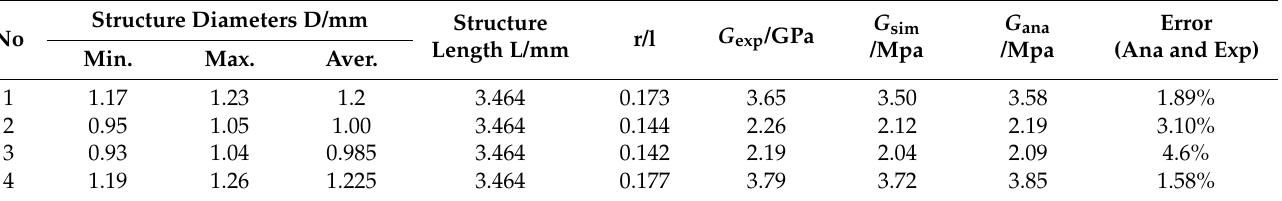
Table 4. Comparison of a multi-layer BCC lattice sandwich structure and equivalent macro shear modulus between experiment, analysis and